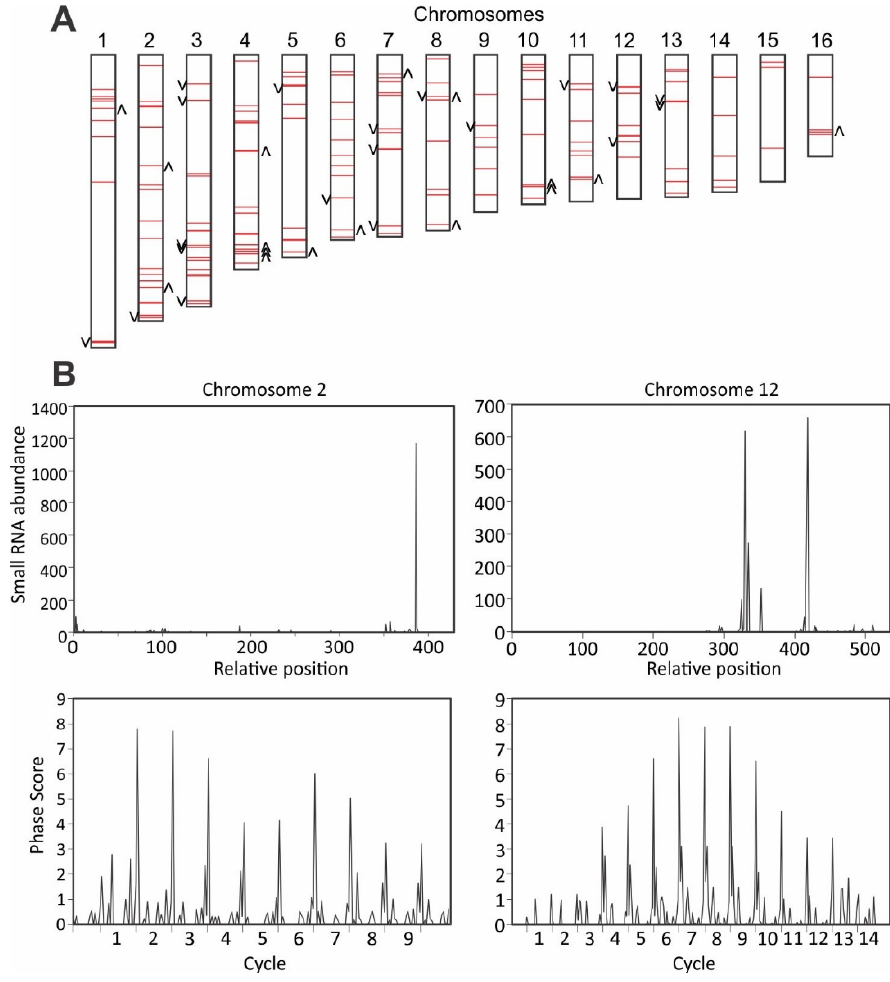
Figure 4. Genome ‐ wide identification of loci producing phased small RNAs in S . sclerotiorum . ( A ) Distribution of loci producing phased small RNAs (red horizontal bars) on S . sclerotiorum chromosomes. Loci marked with asterisks showed significantly different accumulation of small RNAs between mock ‐ inoculated and SsHV2L ‐ infected samples. Asterisks on the left of the bars indicate reduced small RNA accumulation; bars to the right indicate increased small RNA accumulation. ( B ) Small RNA abundances and phasing score distributions across two loci producing phased small RNAs in the S . sclerotiorum genome.